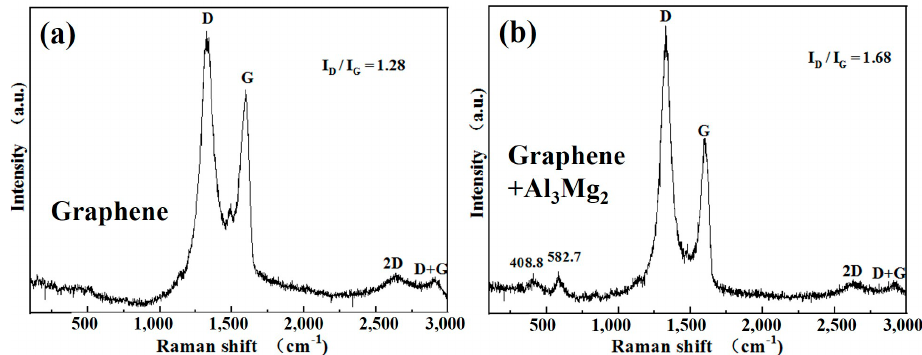
Figure 4. Raman tests on ( a ) multilayer graphene and ( b ) the multilayer graphene-decorated Al 3 Mg 2